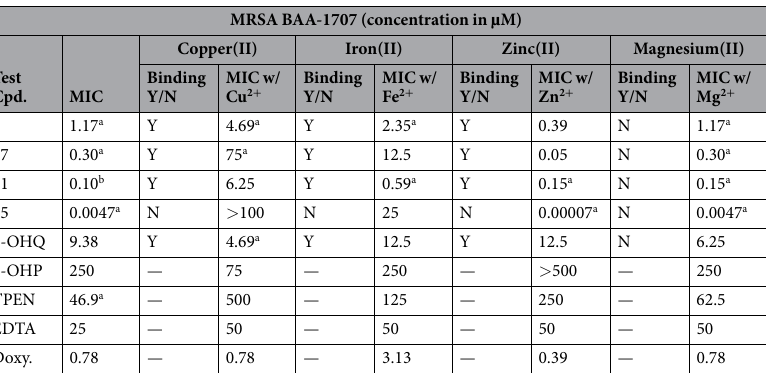
MRSA BAA-1707 (concentration in µ M)